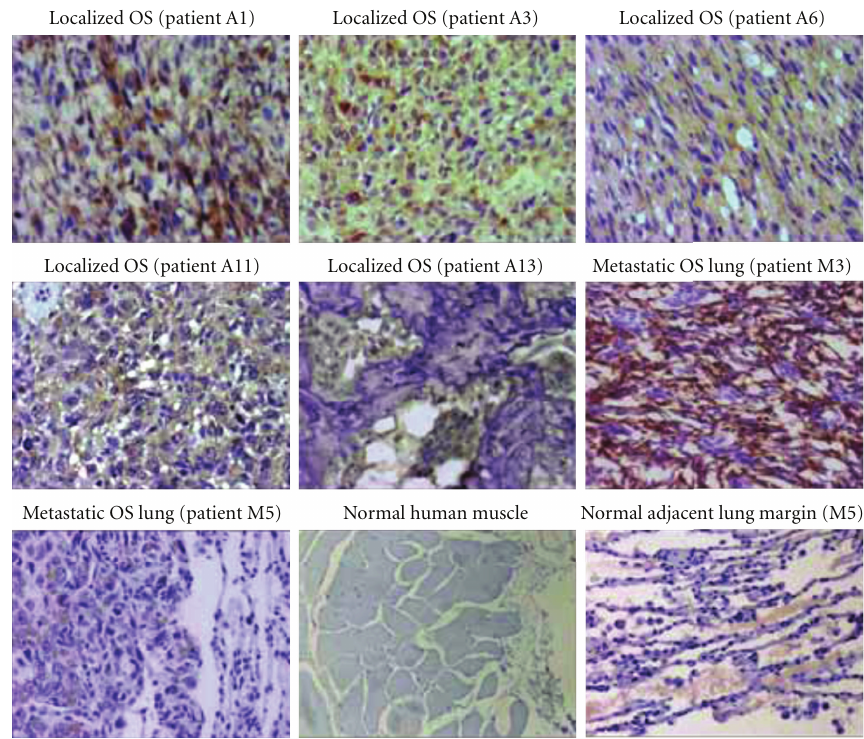
Figure 3: ALCAM expression in human osteosarcoma patient tumor samples. Immunohistochemistry studies in human para ffi n-embedded localized and pulmonary metastatic osteosarcoma samples show mild to strong expression of ALCAM (brown) both membranous and cytoplasmic in appearance in comparison to normal human muscle and human lung. Tissues were counterstained with hematoxylin (magnification